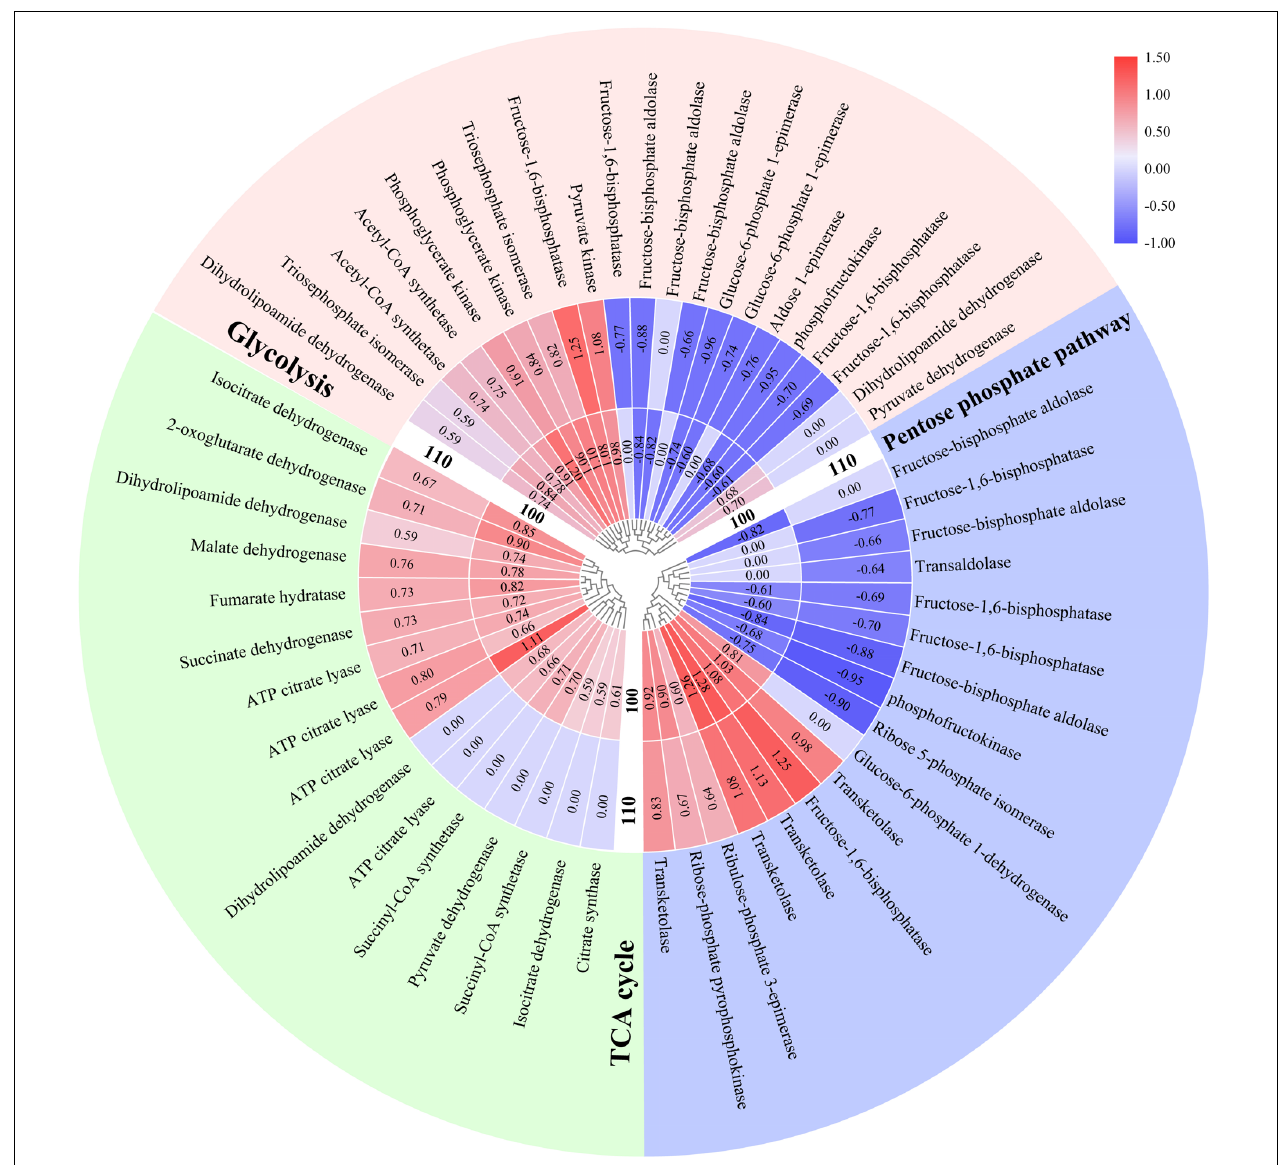
FIGURE 3 | Effects of hypersaline stress on P. haitanensis energy metabolism-related pathways. The heat map was plotted based on log 2 fold change (FC) values from the proteomics dataset. The inside and outside tracks represent the HSS 100 and 110 conditions, respectively. FC ≥ 1.5 and P <